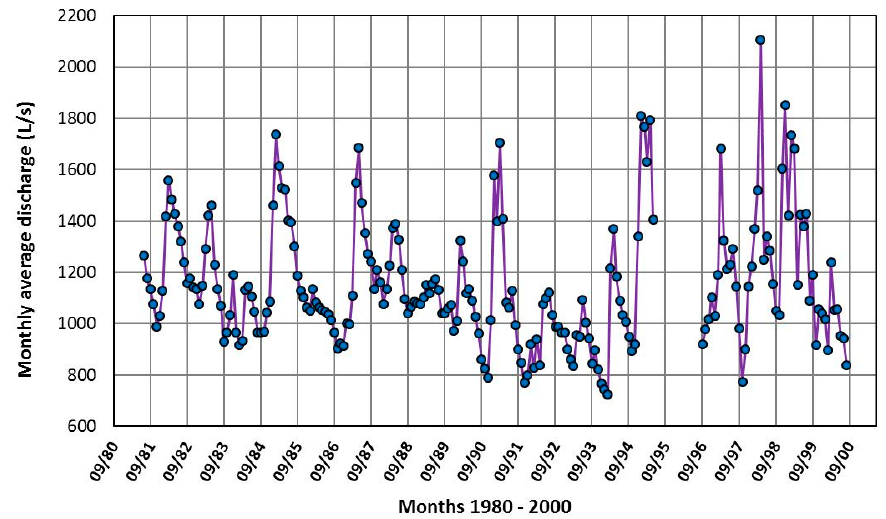
Figure 2. Records of spring discharge between 1981 and 2000.